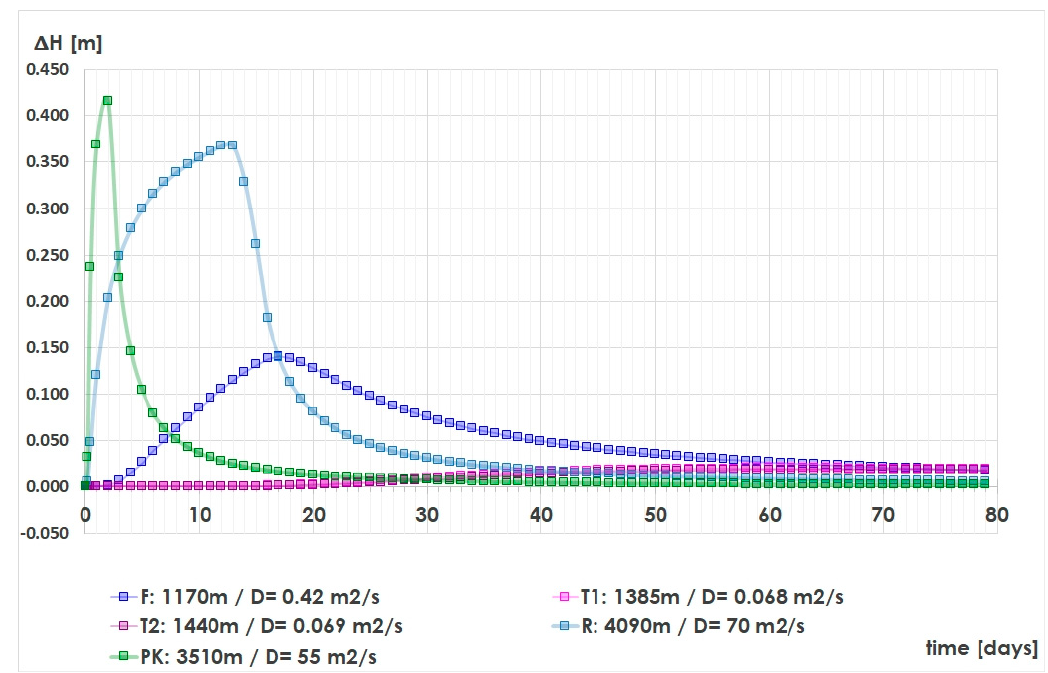
Figure 13. Simulation of groundwater level culmination in various distances from the boundary condition with 10 days lasting water level rise of 0.5 m by superposition of two Gauss error functions. Time shifts of discharge culminations in individual springs were simulated taking into account their distance from the TK-04 borehole.